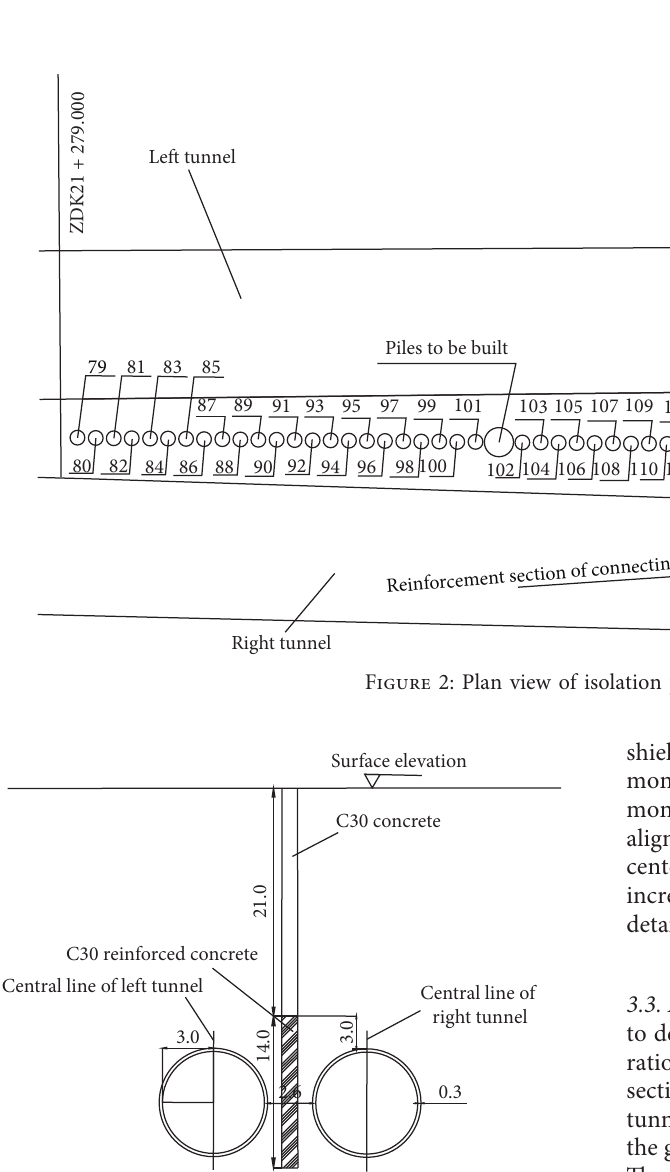
Figure 3: Profile of isolation pile reinforcements.